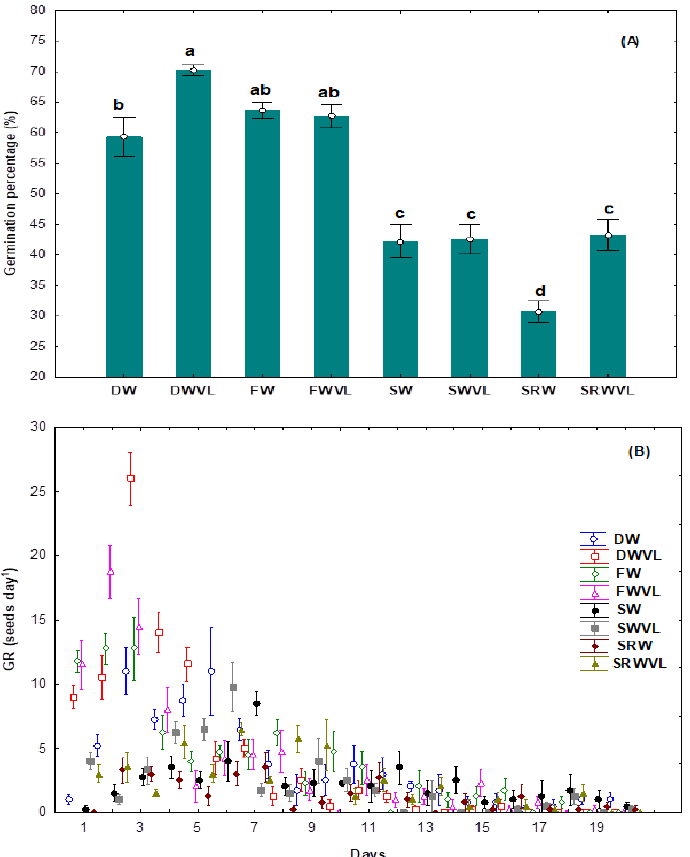
Figure 4. ( A ) Germination percentage of Salicornia bigelovii (GP), same letters above bars denote no-significant differences, and ( B ) germination rate (GR) of seeds under different water treatments; vertical lines at the top of bars ( A ) and on the dots ( B ) are the standard deviation ( n = 4). The germination energy (GE) showed the highest values for DWVL, FW and FWVL, being lower for DW, SWVL and SRWVL; the lowest values were recorded in SW and SRW. GE showed higher values when VL was added to the water sources (Figure 5A). The mean germination time (MGT) decreased in all treatments with VL. This index decreased in 2.7 days with DWVL, compared to DW and SRWVL (Figure